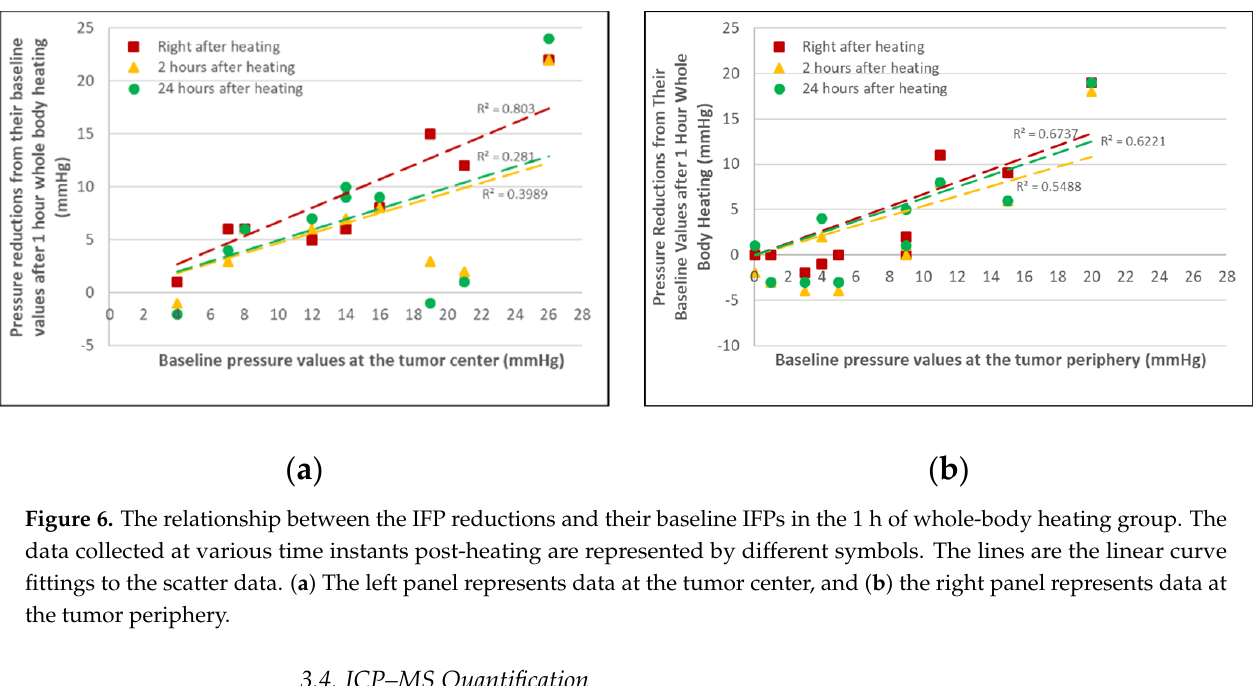
Figure 7. Mean values and standard deviations of the total amount of gold in the resected tumors in the control and heating groups. 4. Discussion As suggested by previous studies [23–25], thermoregulation induced by the elevation of body temperature might contribute to IFP reductions and enhancements in therapeutic agent delivery to tumors. Thermoregulation is controlled by local and central mechanisms to return the body temperature to homeostasis [17]. Nerve cells scattered throughout the